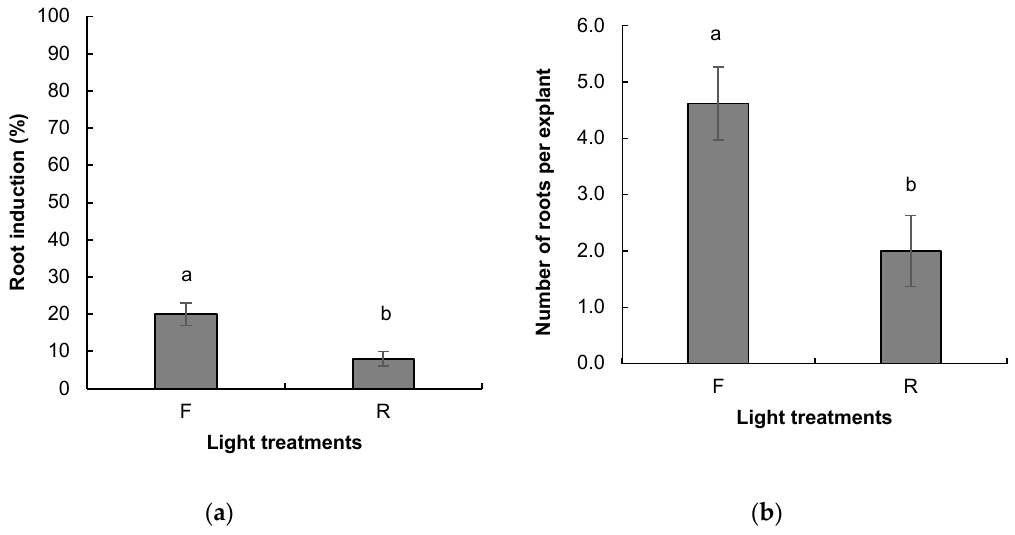
Figure 4. Effect of light treatments (white fluorescent (F) and red LEDs (R)) on root induction (%) ( a ) and number of roots per explant ( b ) of Pinus radiata D. Don shoots cultured in Quoirin and Lepoivre (LP) medium [27], modified according to Aitken-Christie et al. [28]. Data are presented as mean values ± S.E. Different letters indicate significant differences by Tukey’s post hoc test ( a ) and by Duncan’s post hoc test ( b ) ( p < 0.05).